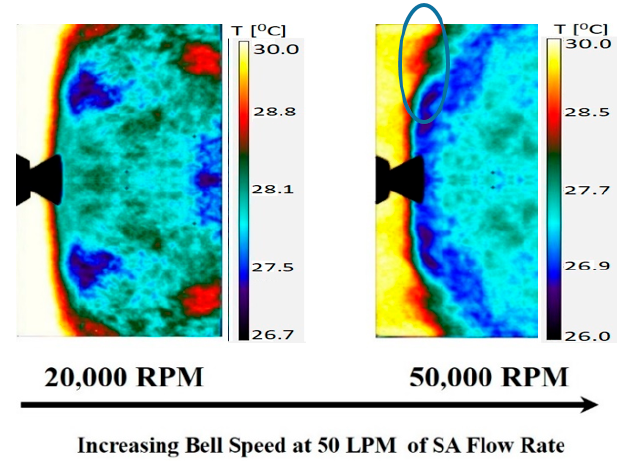
Figure 4. Infrared images of the ERBS Spray at a SA flow rate of 50 LPM, a liquid flow rate of 0.1 LPM, and at 20,000 and 50,000 RPM bell cup speed.